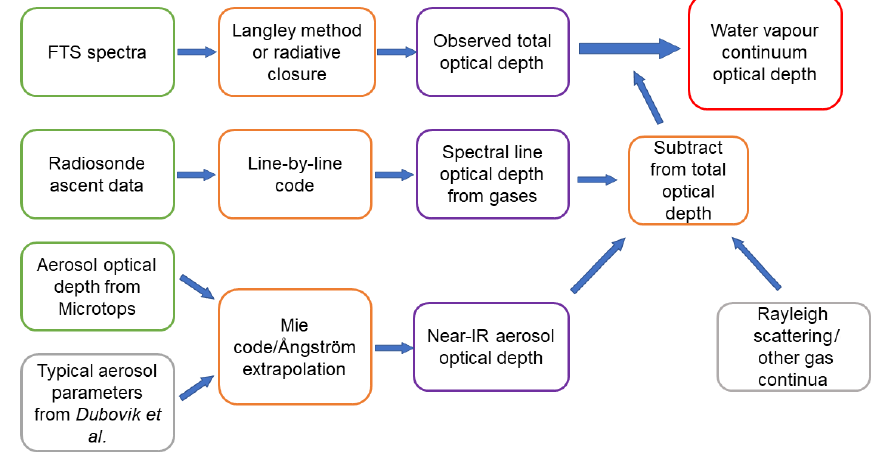
Figure 1. Schematic of the derivation process of the water vapour continuum from the primary data (green), supplementary data (grey), computational methods (orange), intermediate outputs (purple) and final output